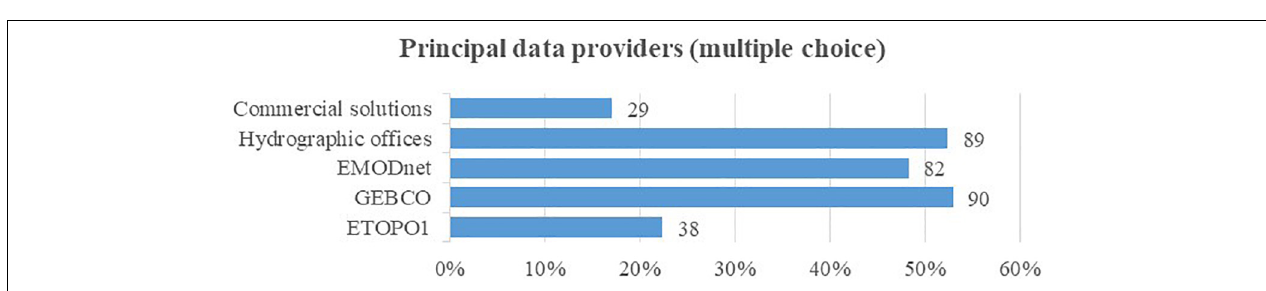
FIGURE 7 | Main market segments of respondents to the survey. The number of users who have selected a given market category is indicated on the right of the bars. The x -axis indicates the percentage of the corresponding users out of 170 respondents.